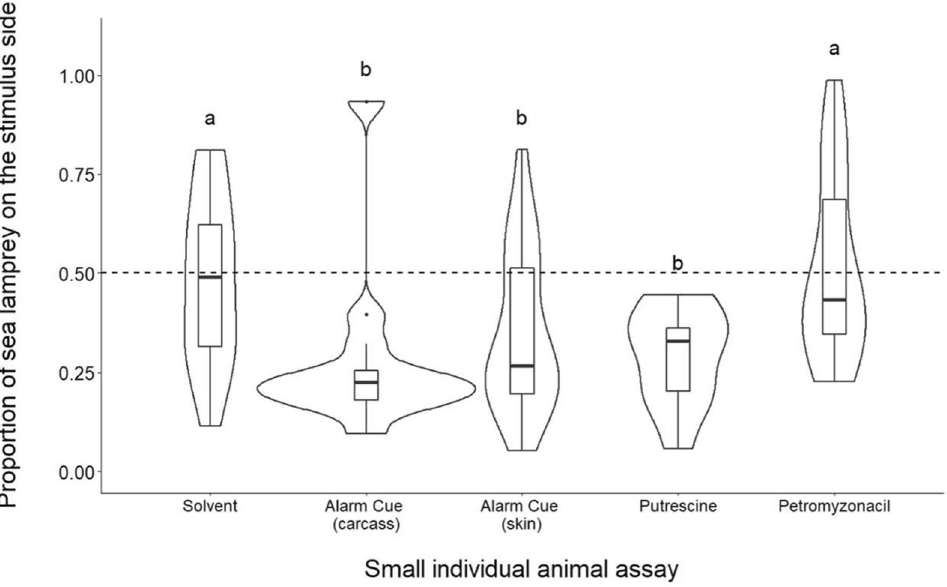
Figure 2. Boxplots representing the proportion of sea lamprey on the stimulus side after the addition of odorants. The middle quartile of boxes represents treatment median, and upper and lower quartiles are the 75th and 25th percentile of the range, respectively. Upper and lower whiskers represent the minimum and maximum spread of the data. Violin plots demonstrate the frequency of proportion values for each treatment. Dashed line at 0.50 represents the null hypothesis of a true neutral response to introduced stimulus. Treatments with different letters are significantly different from one another based on Dunn’s test ( α = 0.05). N = 18 for solvent, N = 13 for full body alarm cue, N = 19 for skin alarm cue, N = 10 for putrescine and N = 19 for petromyzonacil.